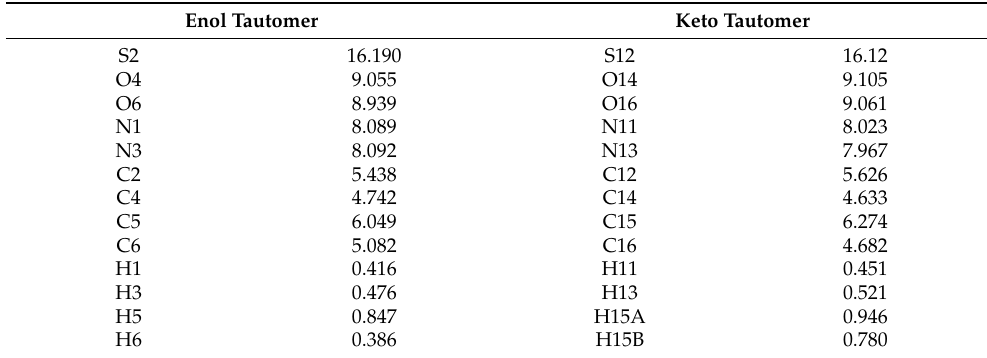
Table 3. Topological atomic charges for TBA tautomers.